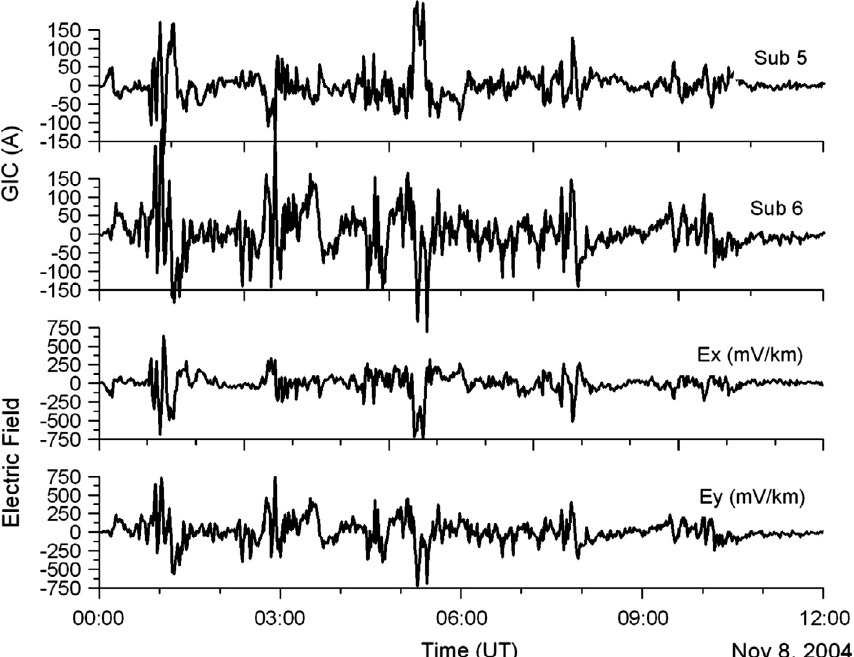
Fig. 8. Calculations made using the Nodal Admittance Matrix method and superposition (Eq. (36)) of results for electric field components E X and E Y calculated using data from the Ottawa magnetic observatory to give the GIC at substations 5 and 6 in the sample network of Figure 7.